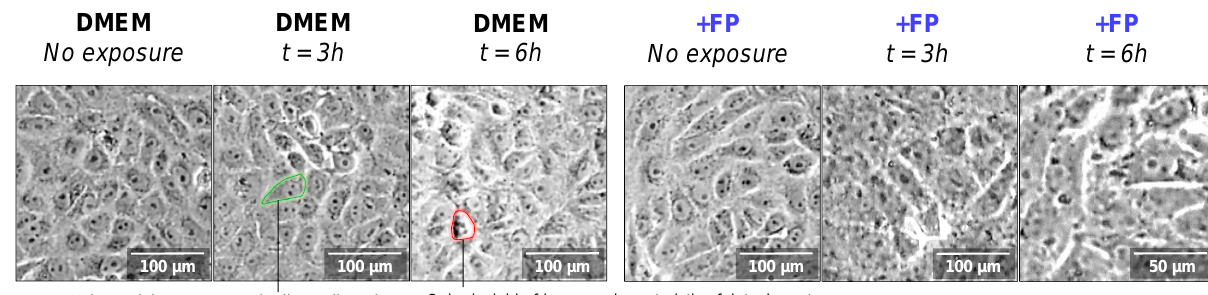
Figure 4. Temporal evolution of Vero cell morphology post-ROS induction with acute H 2 O 2 concentration. Morphologies in the absence of an antioxidant (DMEM) and in the presence of 0.25% FucoPol (+FP) were collected with a 100 × magnification. Notice the absence of birefringence characteristic of cell detachment as a consequence of death. Green indicates a healthy cell, red indicates a dying cell. This evolution is corroborated by the observation of cell morphology (Figure 4). In the sole presence of DMEM, non-exposed Vero cells presented a polygonal aspect, congruent with good cell adherence and function, but there is visible cell detachment with increased exposure time, characteristic of cell death (Figure 4, DMEM). In the presence of 0.25% FucoPol, the healthy attributes of Vero cell morphology were preserved over time, particularly the degree of attachment and cell–cell interactions.